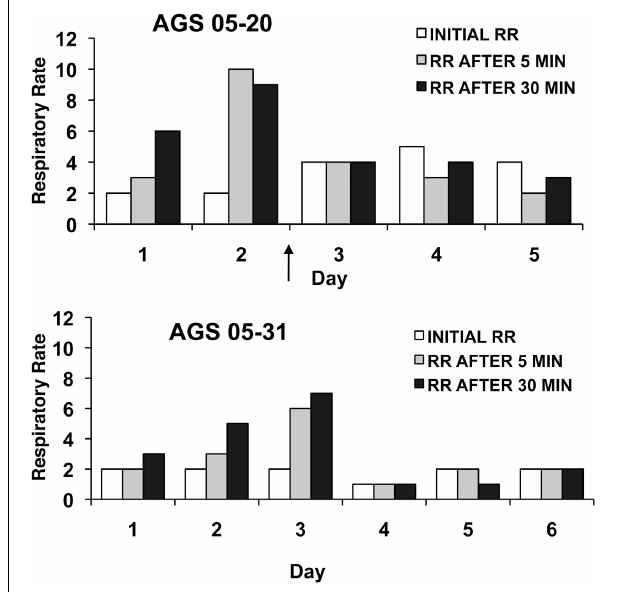
FIGURE 4 | Example of a respiration pattern from an AGS that habituated immediately after an arousal (top panel) and an AGS that did not arouse prior to habituation (bottom panel). Respiratory rate (breaths/minute) were measured prior to handling and movement (initial RR) and 5 and 30min post-handling (RR after 5 or 30min). Top panel shows one animal (identification number: AGS 05-20) over the course of a handling only series of days while the bottom panel shows a different animal (identification number: AGS 05-31) over the course of a handling + movement (7rpm) series of days. Arrow indicates arousal